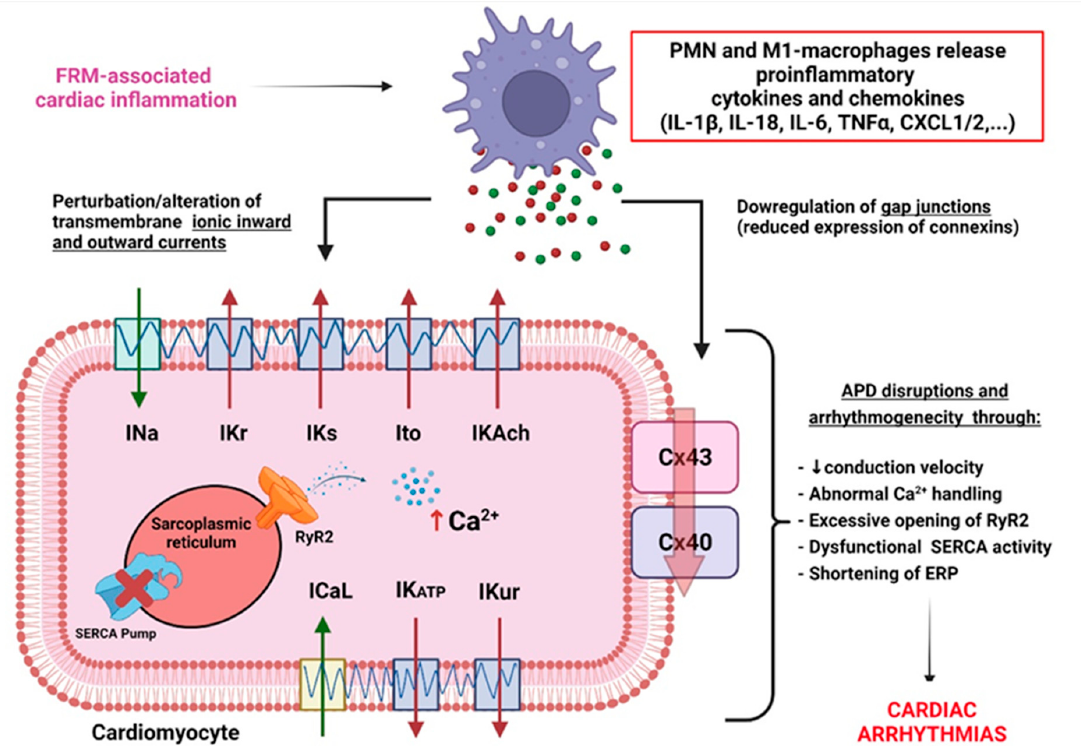
Figure 5. FRM-induced arrhythmogenic channelopathy in cardiac myocytes. In the myocardium, failed resolution mechanisms are associated with increased infiltration of polymophonuclear leuko- cytes (PMN), enhanced M1-macrophages phagocytic activity and augmentation of the secretion of proinflammatory cytokines. Persistence of proinflammatory signals provokes deregulation of gene coding for key ion-channels and connexins involved in the establishment of cardiac action potential (AP) and conduction velocity. Inflammation-associated channelopathy induces: abnormal calcium- (Ca 2+ )-handling, effective refractory period (ERP) shortening, reduced AP duration (APD), slowed conduction, vulnerability to re-entry, and triggered activity leading to increased risk of cardiac ar- rhythmias and fibrillation.